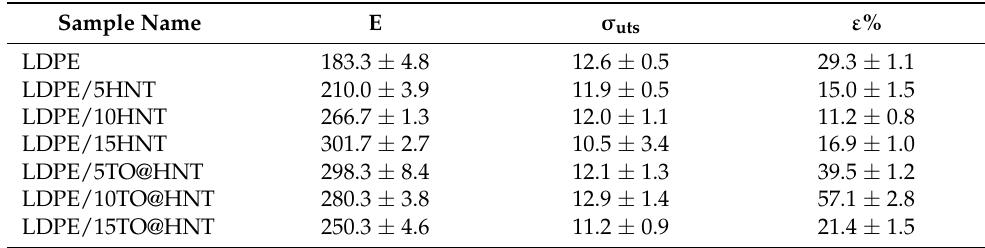
Table 1. Calculated values of Young’s (E) modulus, ultimate tensile strength ( σ uts ), and % strain at break ( ε b ).